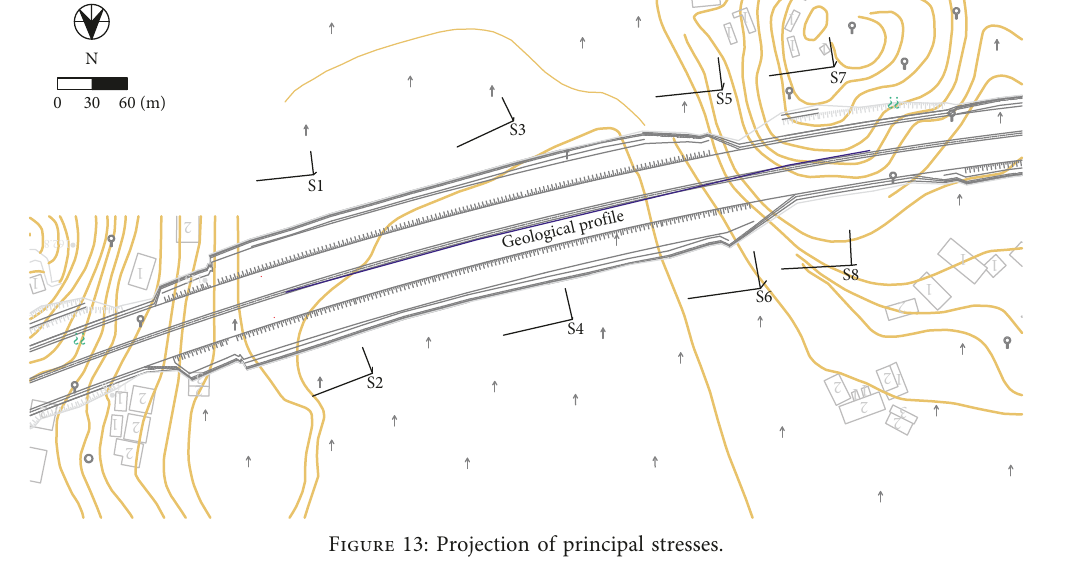
Figure 13: Projection of principal stresses.